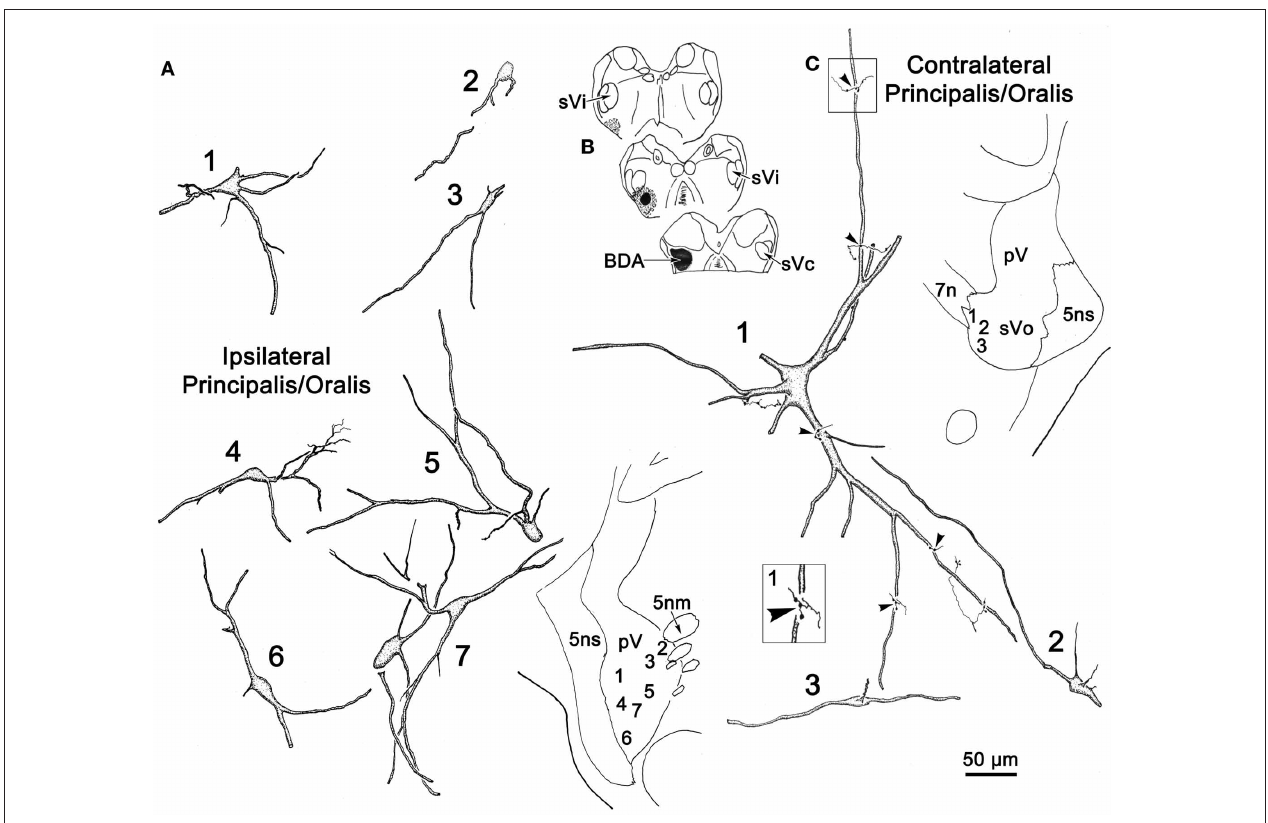
FIGURE 7 | A unilateral injection into sVc is shown in (B). (A,C) illustrate the morphology of the cells labeled following this injection, which were seen in the border region between pV and sVo on the ipsilateral (A)